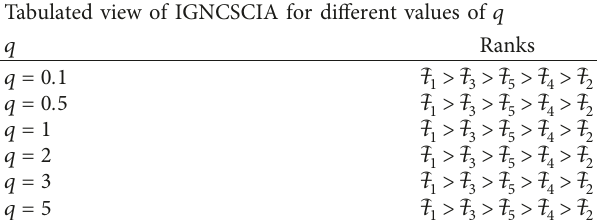
Table 4: The ranking of alternatives subject to the different values of q using the IGNCSCIA operator. Tabulated view of IGNCSCIA for different values of q